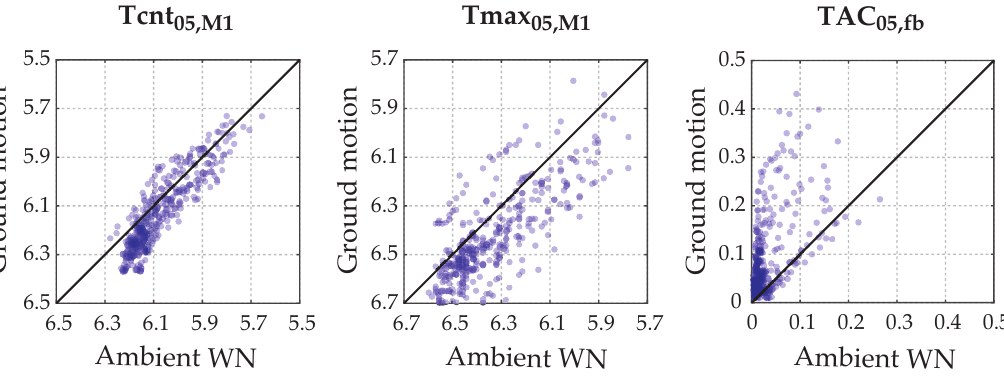
Figure 9. Comparison of transmissibility-based DSFs derived from AVs with their counterpart derived from strong GMs. While the scatter is low for T c nt ( left ), a noticeable scatter appears for T max ( center ). When evaluating the TAC ( right ), the data obtained from ground motions are more sensitive to damage, with the values lying above the